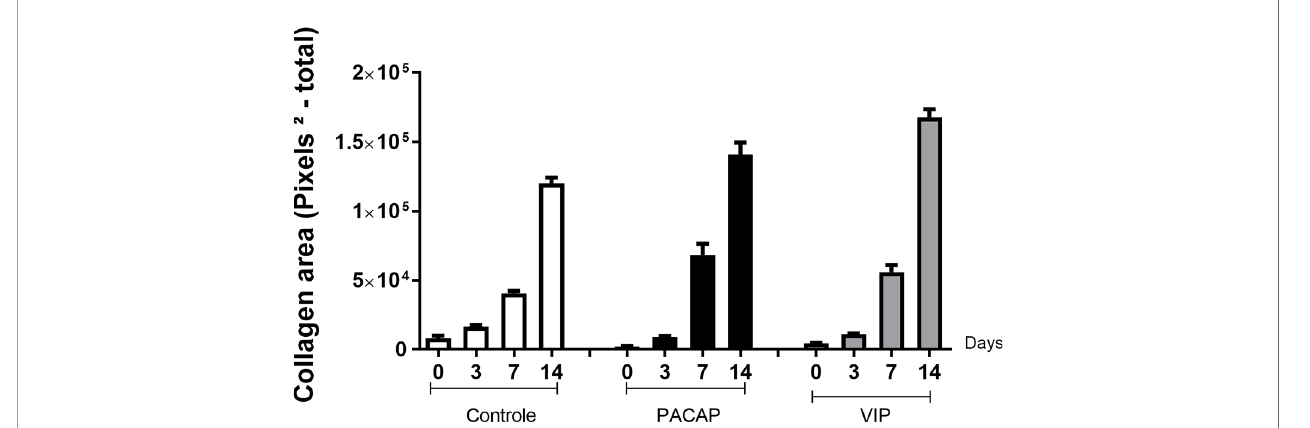
FIGURE 11 | Quantitative analysis of the area (pixels 2 — total) occupied by birefringent collagenous fi bers in the dental alveoli at 0, 3-, 7-, and 14-day post-exodontia periods, in the control and treated with PACAP and VIP. Periods of 0, 3, 7 and 14 days represented in relation to the area in pixels 2 of birefringent fi bers relative to the total area, throughout the experimental periods. The results represent the values of the mean and standard deviation in each of the periods